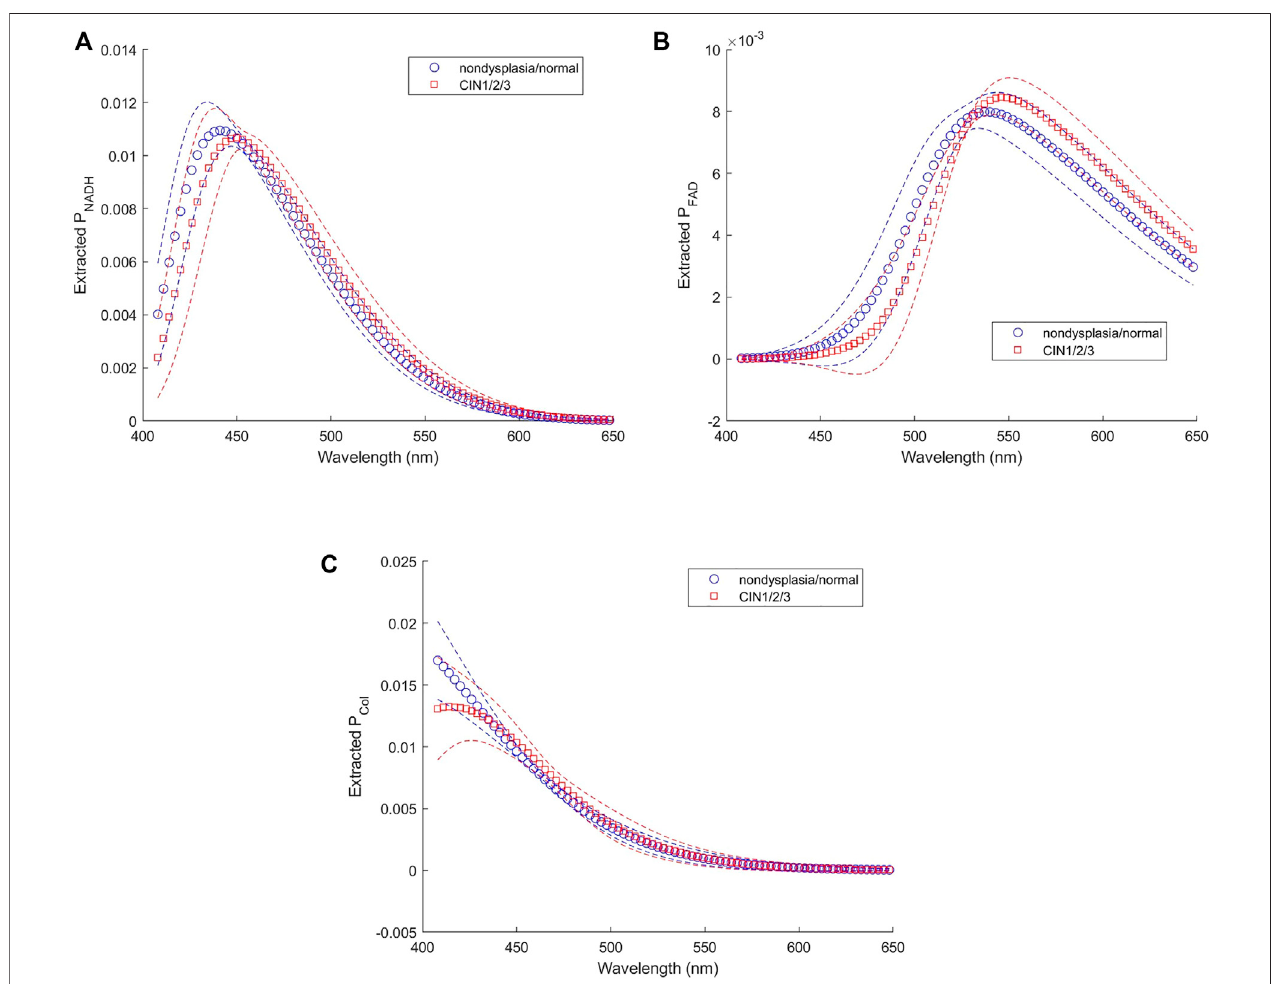
FIGURE 10 | Intrinsic fl uorescence spectra of (A) NADH, (B) FAD, and (C) collagen extracted from in-vivo data.